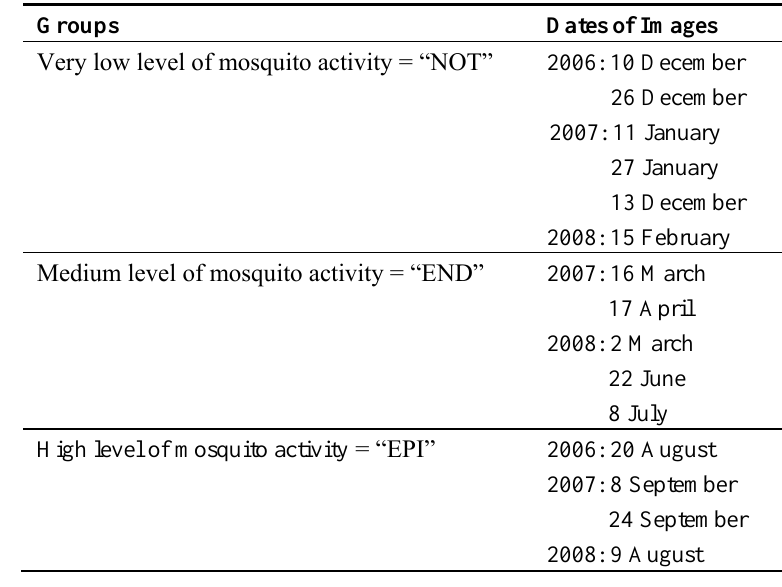
Table 1. Groups of Landsat Images depending on the level of mosquito activity in the Camargue region, Southern